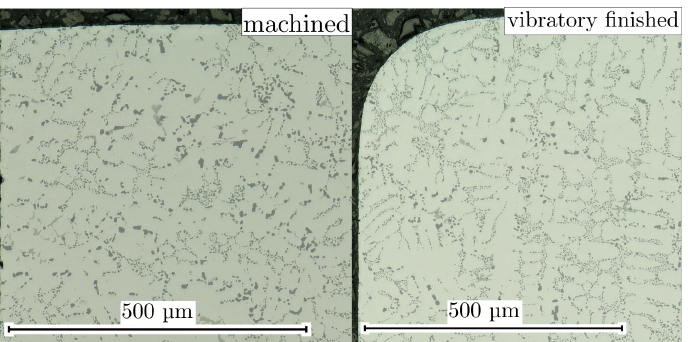
Figure 5. Comparison of AlSi-cast specimen cross sections in machined and vibratory finished